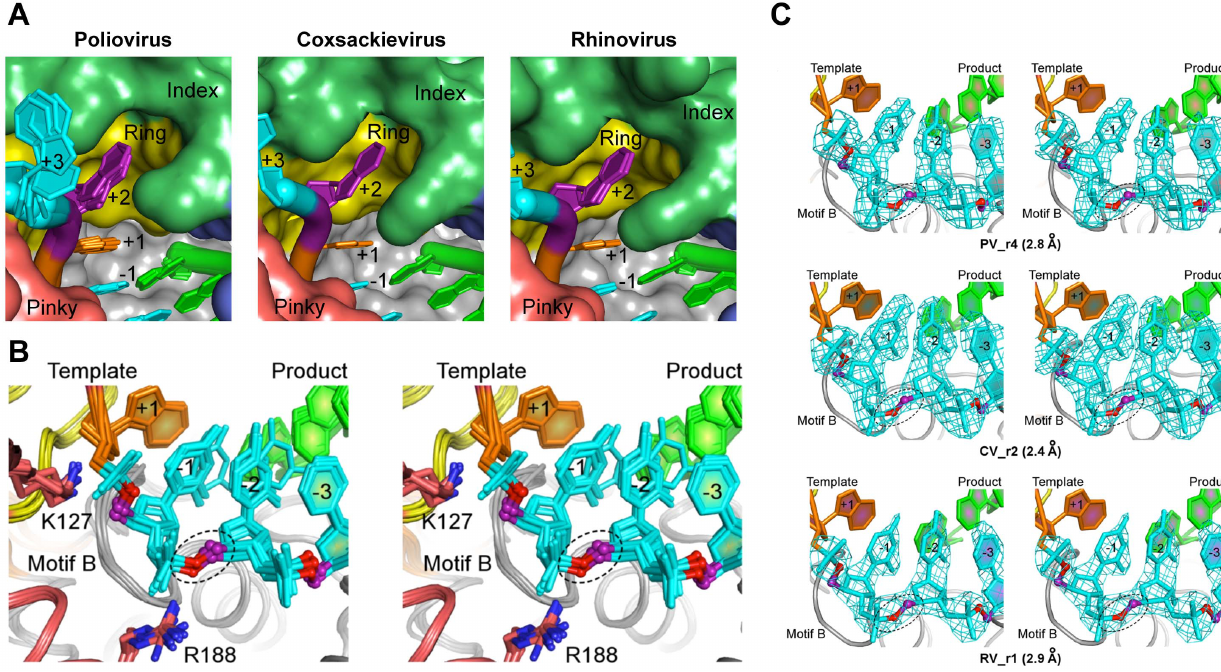
Figure 7. Conservation of RNA active site conformation. A) Top view looking at the downstream template RNAs from all ECs as it enters the active site. The + 2 template strand nucleotide (purple) is consistently bound in a pocket formed by the polymerase index and ring fingers and the templating + 1 nucleotide (orange) is always fully pre-positioned for base pairing with an incoming NTP in the active site. B) Stereo images of the RNA template strand conformation from positions 2 3 to + 1 showing RdRP motif B positioned directly beneath the -1 position ribose of the template strand. The backbone of the -2 template strand nucleotide always has a different conformation than the neighboring A-form RNA helix nucleotides that is due to a 120 u rotation about its ribose C5 9 - O5 9 bond (dashed circle). C) Stereo images of composite SA-omit electron density maps (3500 K, 1.5 s ) showing RNA density in the vicinity of the conserved non-standard backbone conformation of the 2 2 template strand nucleotide.